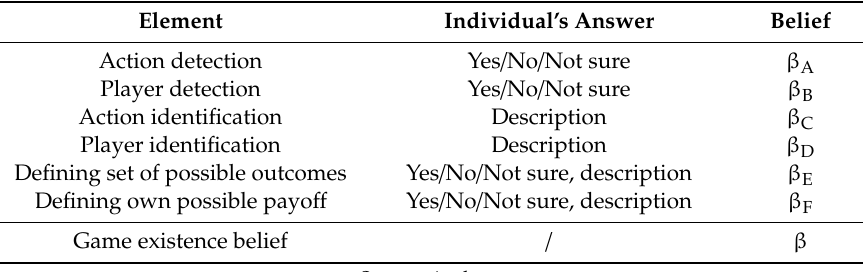
Table 1. Game elements detection and identification with associated